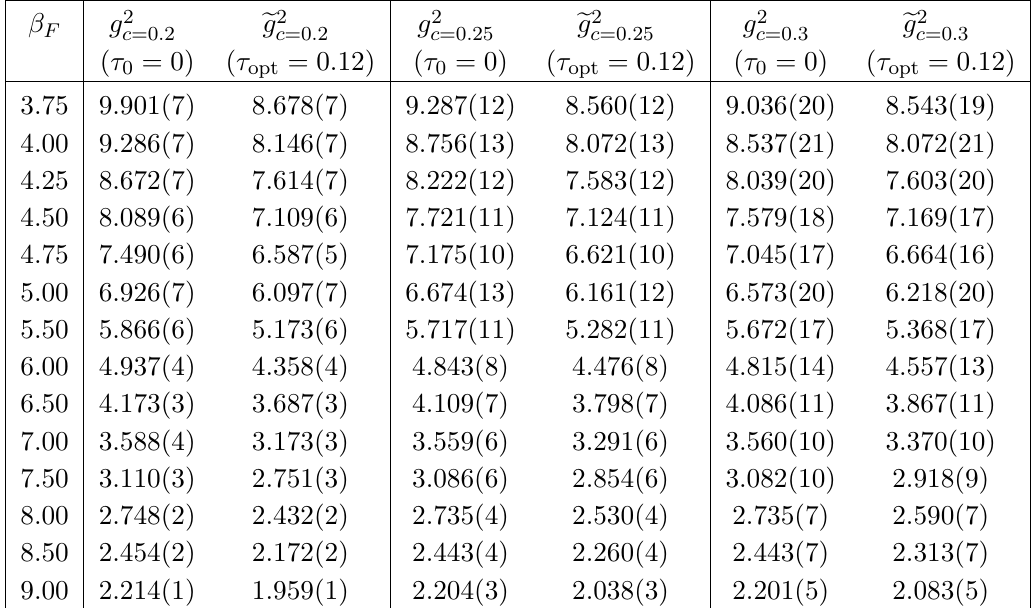
Table 18 . Renormalized gradient (cid:13)ow couplings based on the plaquette discretization of E ( t ) for the 20 4 lattice ensembles used in this work, with columns as in table